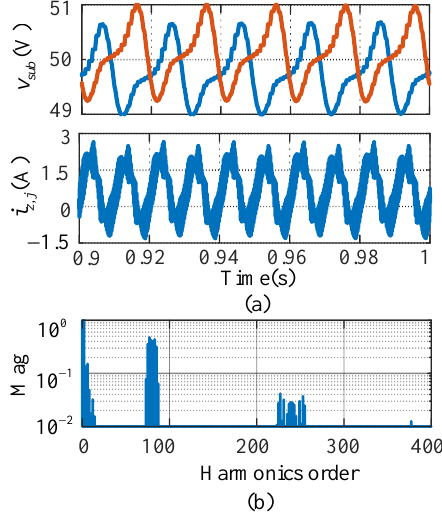
Figure 14. Simulation results of PSC1. ( a ) Capacitor voltage of SMs and circulating current. ( b ) FFT analysis of circulating